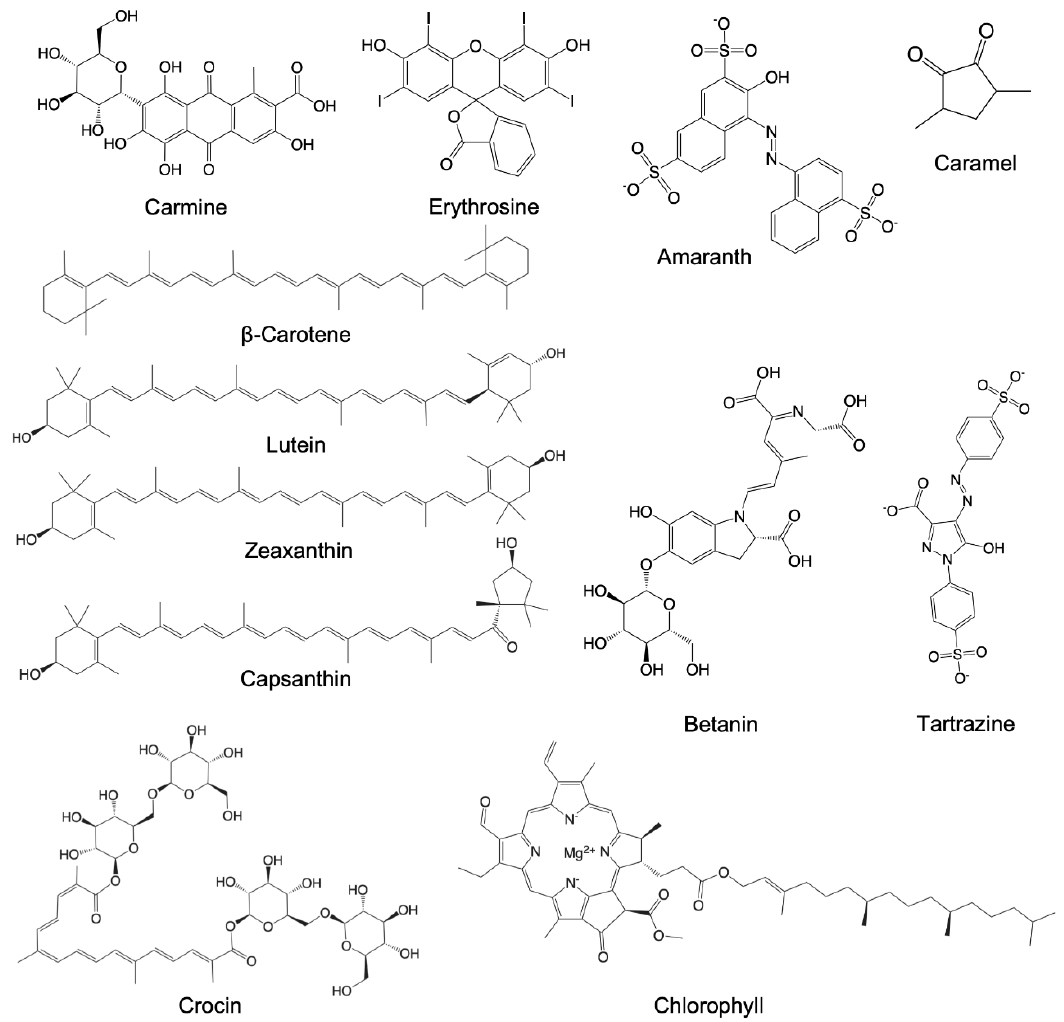
Figure 1. Chemical structures of food colorants. Some food colorants, including fruit-green, purple sweet potato color (PSPC) and sorghum red are commercially available, but are a mixture; therefore, the main structures of these food colorants were not shown.